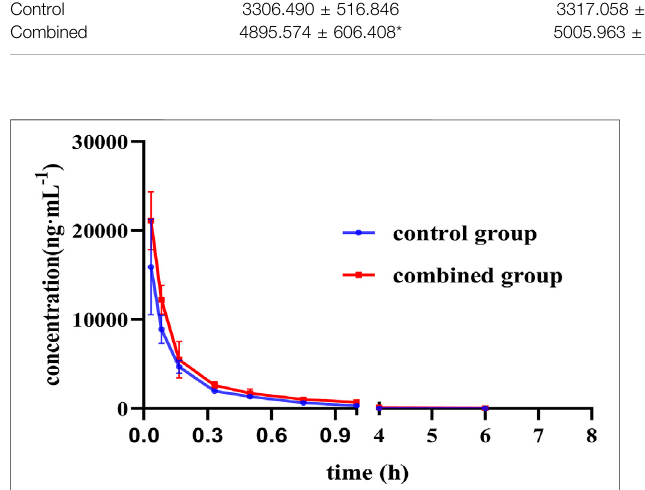
FIGURE 6 | Mean plasma concentration – time curve of PG in different groups ( n = 8).